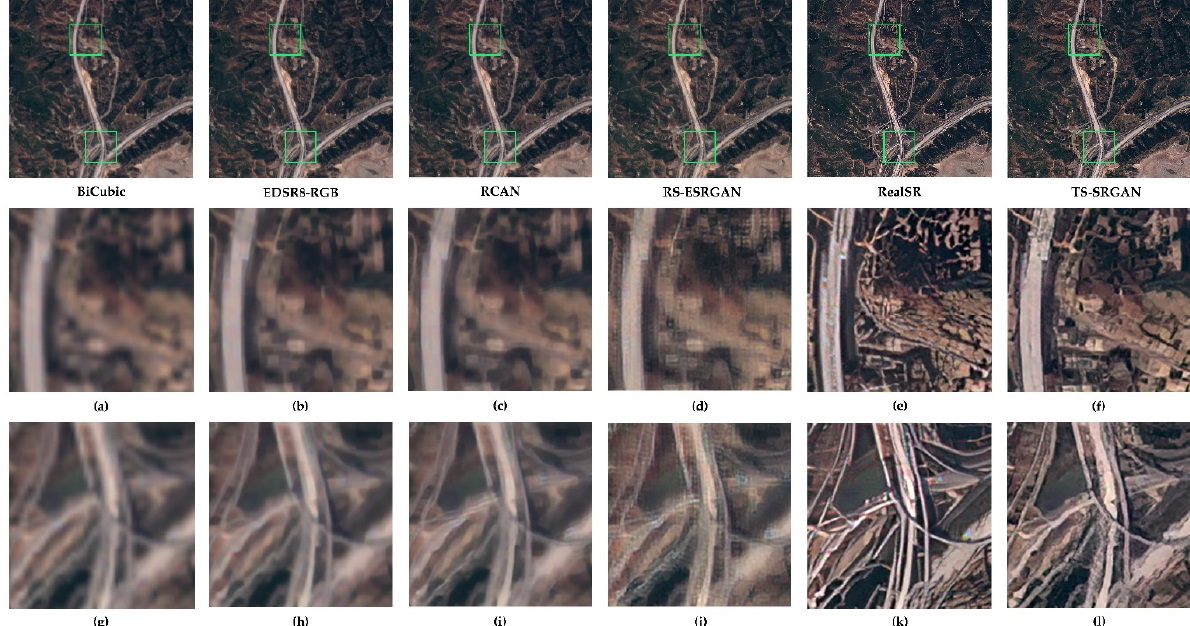
Figure 21. Comparison of visual effects of the generated images of the region containing overpasses. NR-IQA of images (NIQE, BRISQUE, PIQE): BiCubic (6.39, 54.32, 94.91), EDSR8-RGB (5.68, 49.28, 81.34), RCAN (4.83, 47.54, 68.32), RS-ESRGAN (2.95, 19.71, 12.84), RealSR (3.46, 13.37, 7.75), TS- SRGAN (2.68, 18.06, 10.60). The subfigures ( a – l ) in the figure represent an enlarged view of the local details in the green boxes in the generated image.